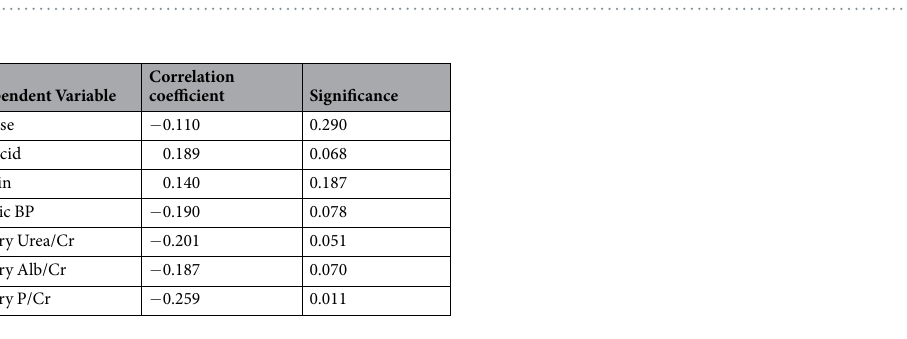
Table 4. Simple Linear Correlation analysis. Dependent variable: Rate of change in eGFR. eGFR: Estimated Glomerular Filtration Rate; BP: blood pressure; Cr: creatinine; Alb: albumin; P: